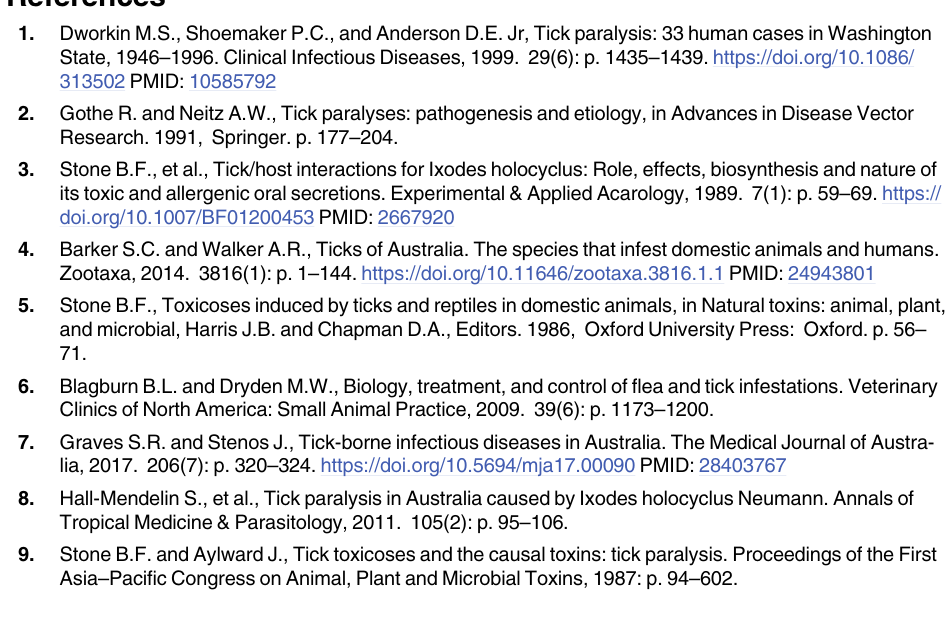
S1 Table. Assumptions of predictor models used to forecast paralysis tick admission cases to Sunshine Coast veterinary clinics and build the ensemble forecast. ARIMA, Autoregres- sive Integrated Moving Average; GARCH; Generalized Autoregressive Conditional Heteroske- dasticity; GAM, Generalized Additive Model; ETS, exponential smoothing. (DOCX) S1 Data. Data and R code to replicate ensemble modelling and particle filtering and associ- ated figures. Model results from this study are included in the Intermediate_outputs folder.